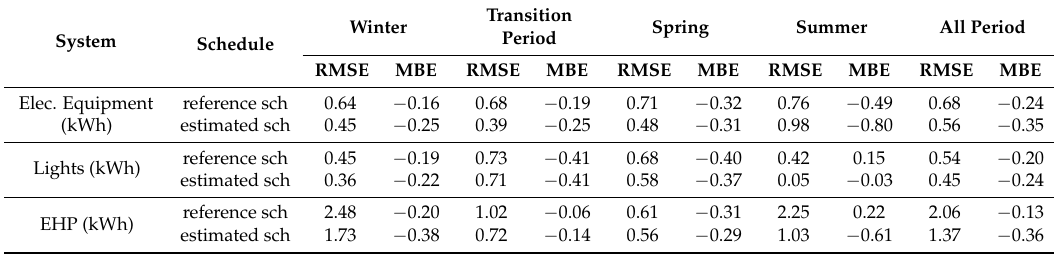
Table 12. Margin of errors in energy consumption estimation results using the reference and